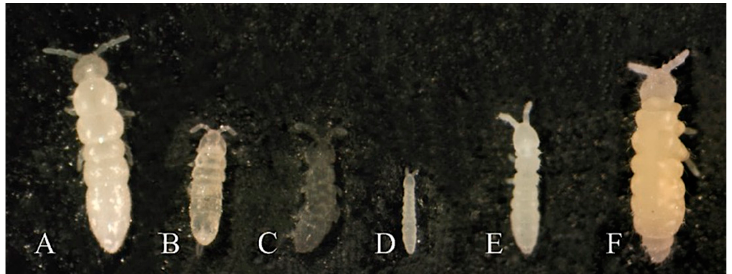
Figure 1. Collembolan species used in the avoidance test: Folsomia candida ( A ), Folsomia fimetaria ( B ), Proisotoma minuta ( C ), Mesaphorura macrochaeta ( D ), Protaphorura fimata ( E ) and Ceratophysella denticulata ( F ).